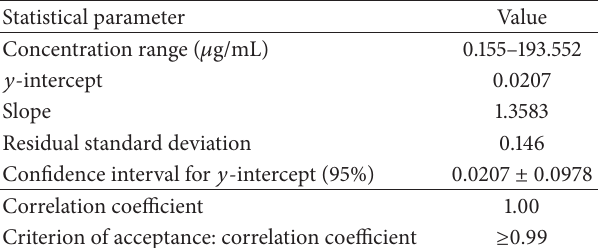
Table 2: Results of repeatability.